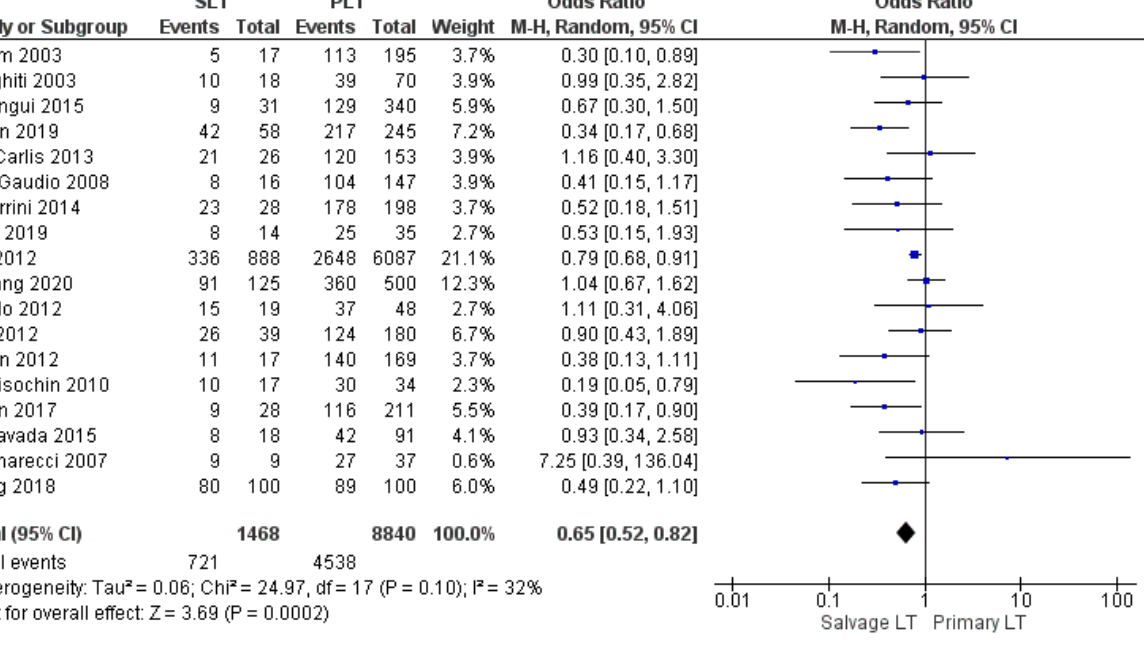
Figure 22. 5- year disease free survival rates. Figure 22. 5-year disease free survival